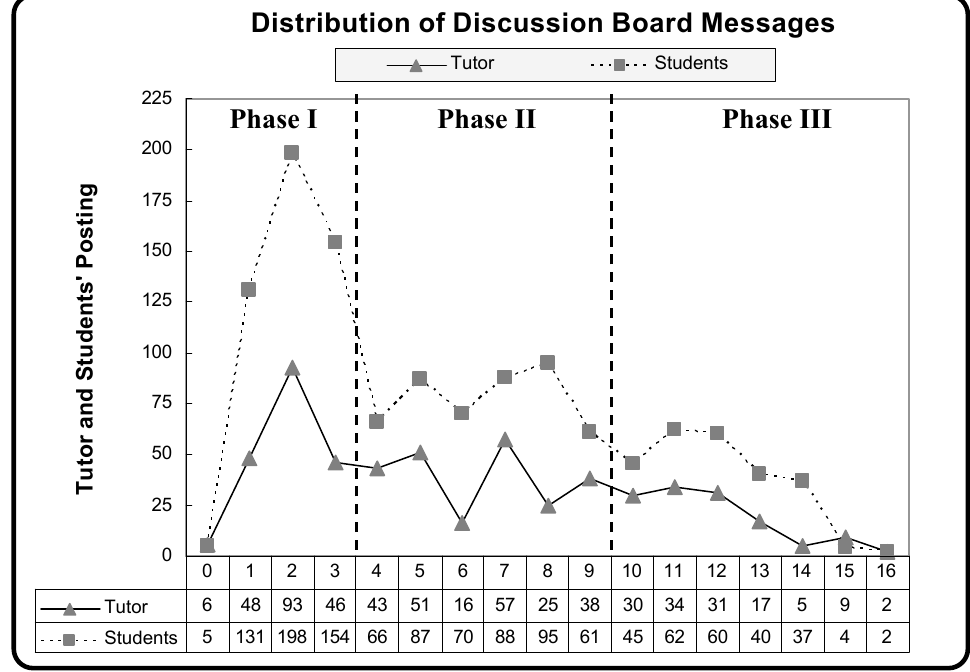
Figure 1. Overall distribution of discussion board postings from week 0 to week 16 Data were then analysed cumulatively for the full 17-week period according to the coding categories identified for this case study. In other words, a matrix summarising